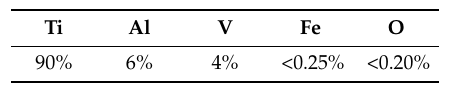
Table 2. Mechanical and physical properties of Ti6Al4V.